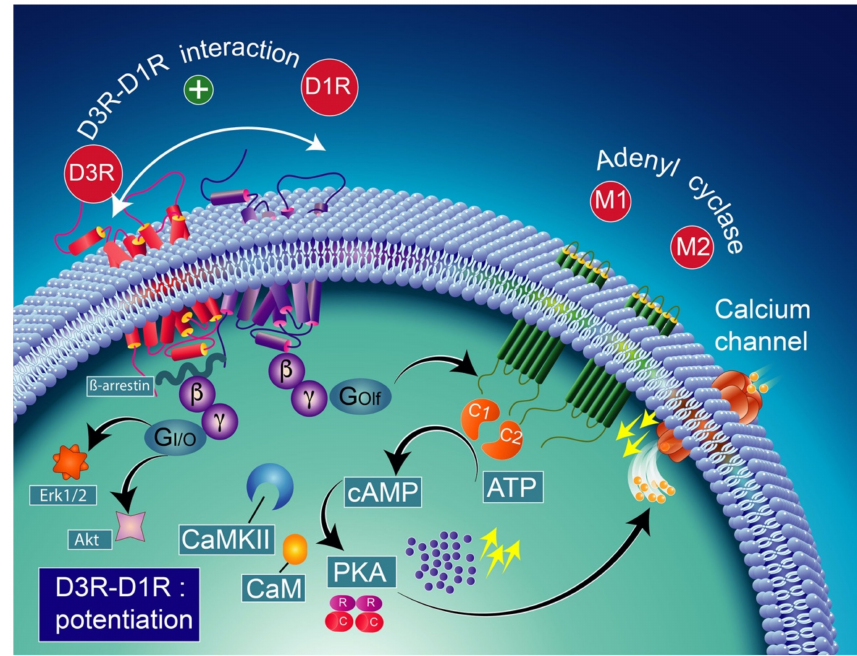
Figure 4. D1R and D3R interaction in basal conditions considering the colocalization of D1R and D3R in medium spiny GABAergic/substance P-positive neurons [248,249]. The activation of the D3R has a synergistic effect on the D1R, increasing the levels of adenylyl cyclase (mostly the AC5 isoform) through the stimulatory heterodimeric Golf α subunit, leading to the pro- duction of cAMP [238,250] which results in the activation of PKA and GABA release. CAM- calmodulin; CaMKII-calcium/calmodulin-dependent protein kinase II; PKA-protein kinase A; PDE- cAMP phosphodiesterase; AMP-5 (cid:48) adenosine monophosphate-activated protein kinase; cAMP-cyclic adenosine monophosphate; Erk1/2-extracellular signal-regulated protein kinases 1 and 2; Akt-ser- ine/threonine